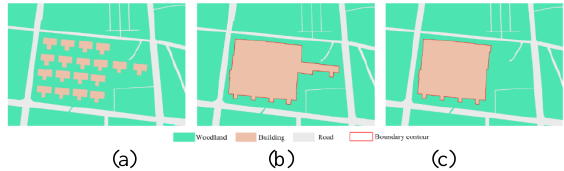
Figure 11. Comparison of merging results for the complex grid pattern. (a) Original data; (b) result of mixed integer programming; (c) result of the method proposed in this paper. Figure 10 indicates that the mixed integer programming method